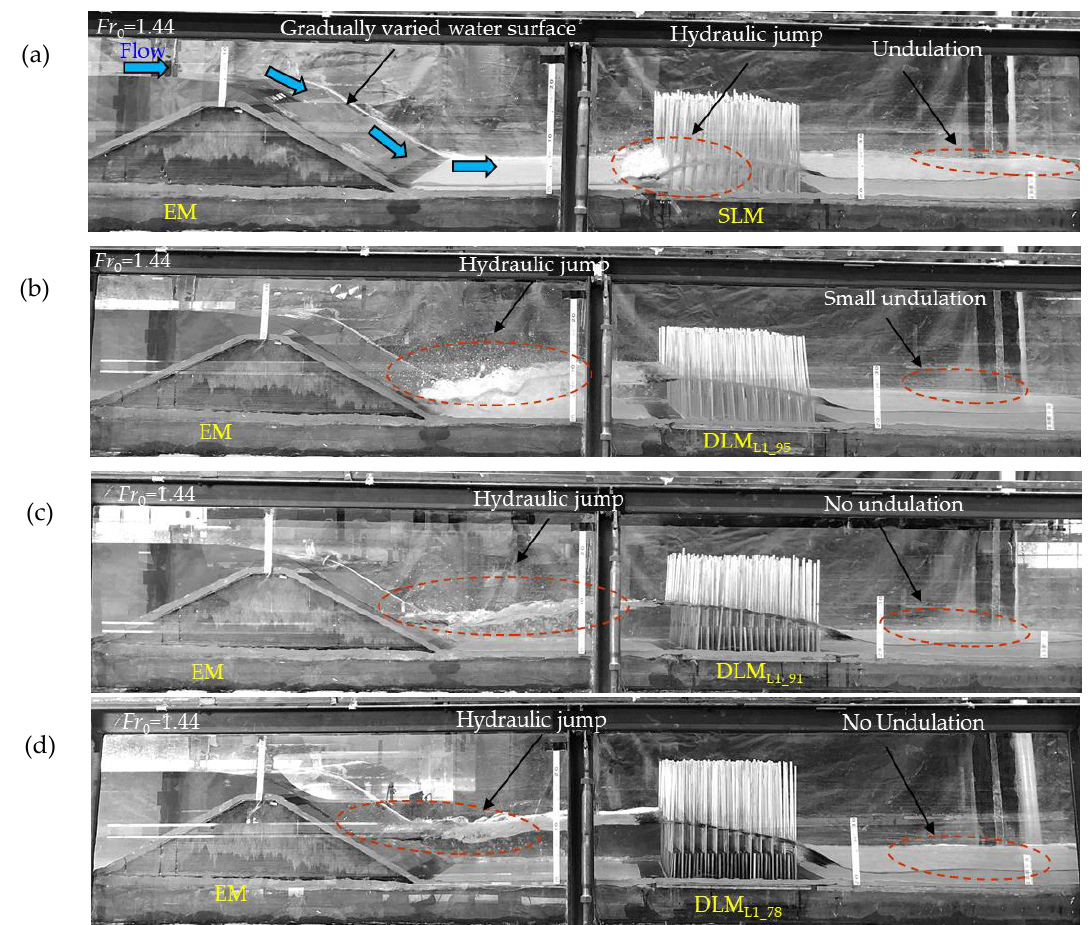
Figure 5. Classification of flow structure for different forest models and hydraulic conditions. Where the horizontal axis represents porosity ( Pr ) of L1 (Submerged Layer) and the vertical axis represents initial Froude number ( Fr 0 ); the dotted line represents the separation between Type A and Type B jumps.